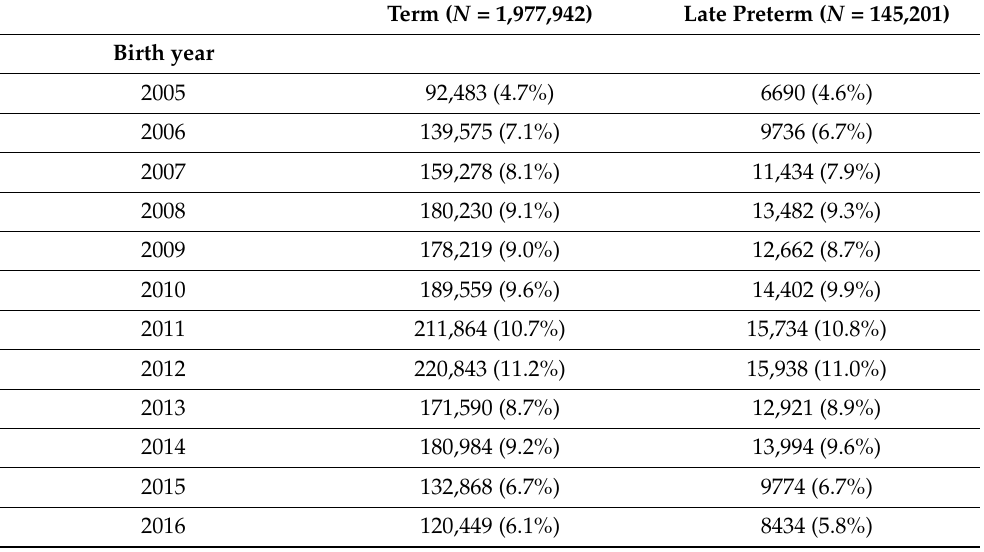
Table 1. Infant characteristics stratified by gestational age.